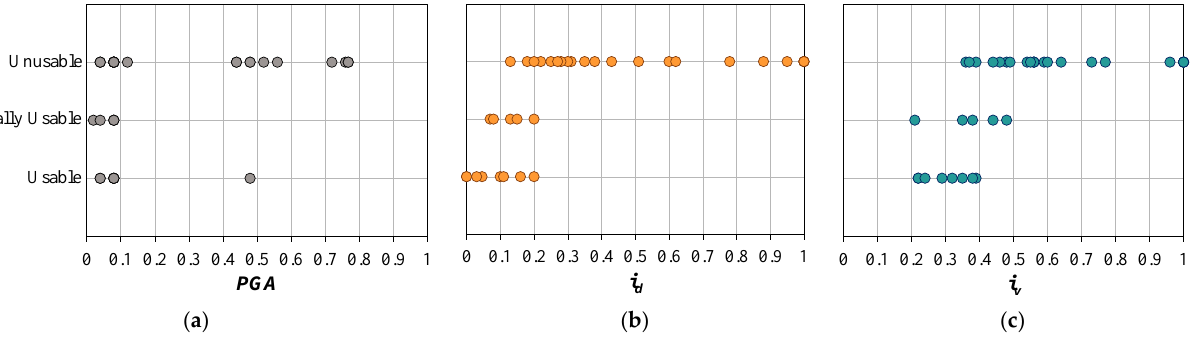
Figure 24. Correlation between usability assessment, PGA ( a ), global damage index evaluated according to Equation (2) ( b ), and vulnerability index defined according to LV1 approach ( c ).